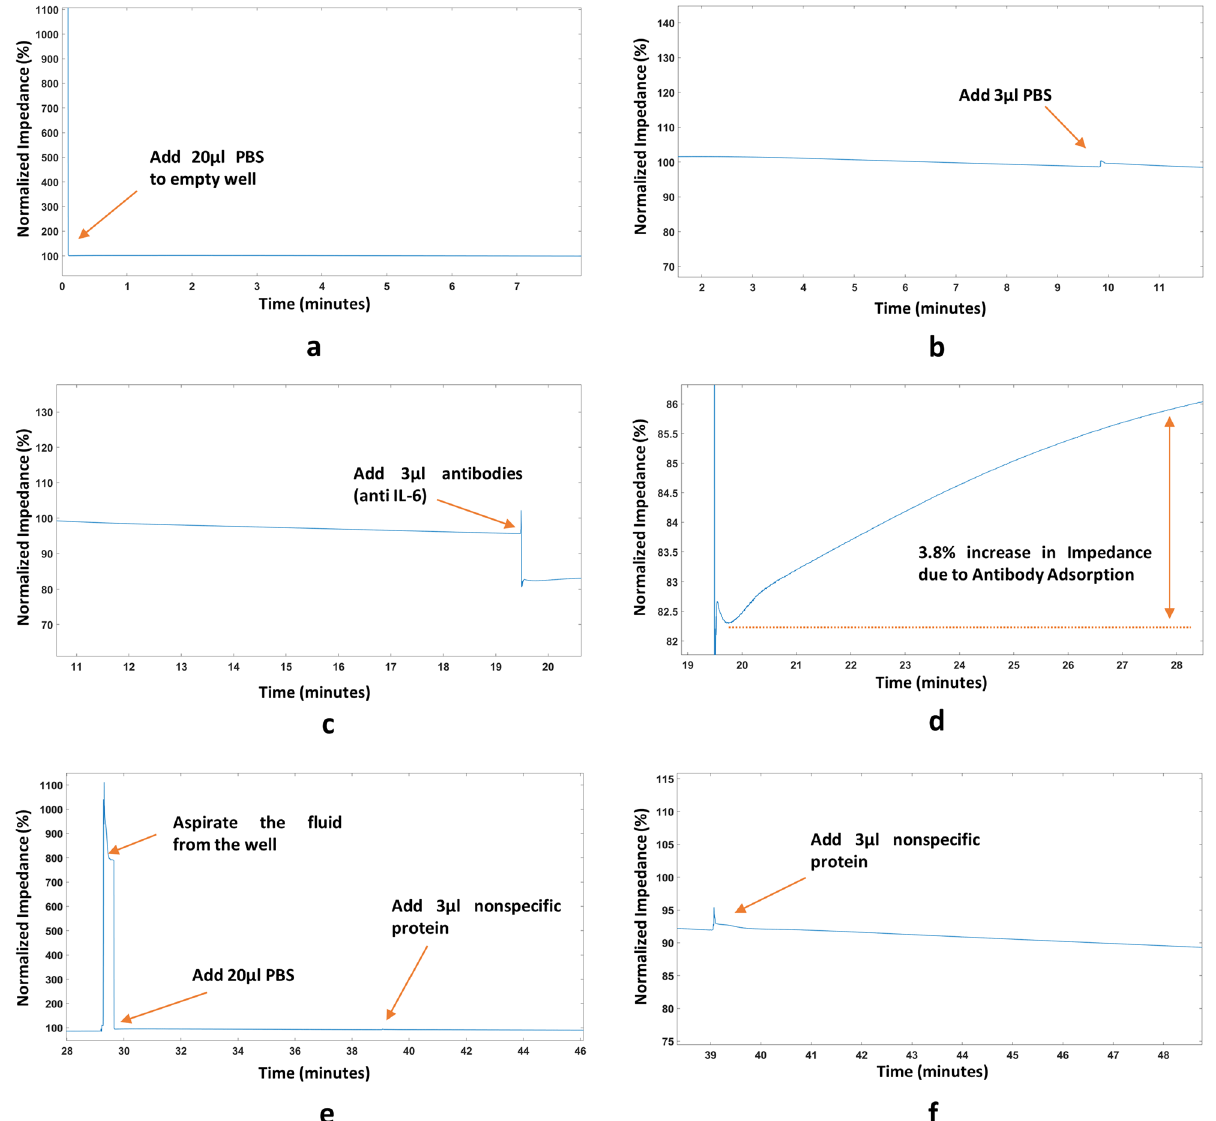
Figure 5. Nonspecific protein experiment (Negative Control) ( a ) Adding 20 μl PBS to an empty nanowell sensor ( b ) Adding 3 μl PBS to the sensor ( c ) Adding antibodies (anti IL-6) to the sensor ( d ) Approximately 3.8% increase in impedance due to antibody adsorption ( e ) Clearing the nanowell sensor by pipetting out solution and adding 20 μl PBS before adding 3 μl of Recombinant Human SARS-CoV-2 Spike Glycoprotein S1 (ab272105, Abcam) ( f ) Approximately -1.3% change in impedance observed. This is similar to adding PBS to the